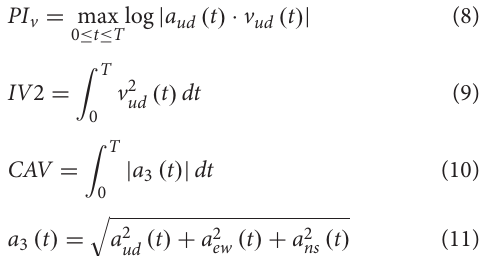
in Supplementary Table 5